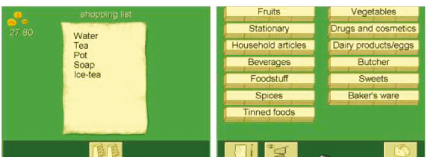
Figure 9: Example of a shopping list on level 14, of the Shopping RehaCom module (from level 11 onward, an amount of money the patient has at his/her disposal is displayed in the upper left of the